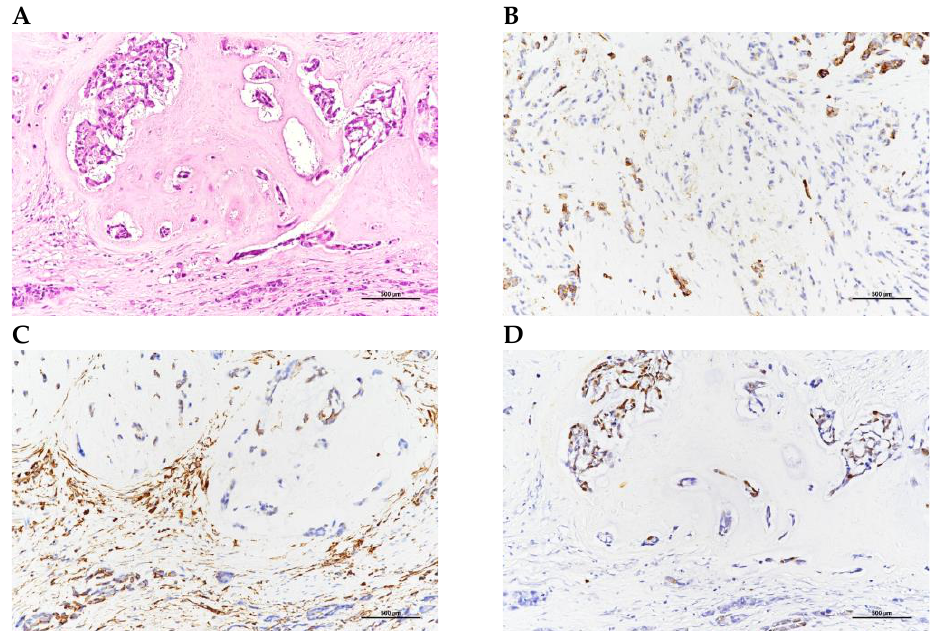
Figure 2. Pathological sections with immunoprofile. ( A ) HE stain; ( B ) CK (+); ( C ) vimentin (+); and ( D ) S100 (+).